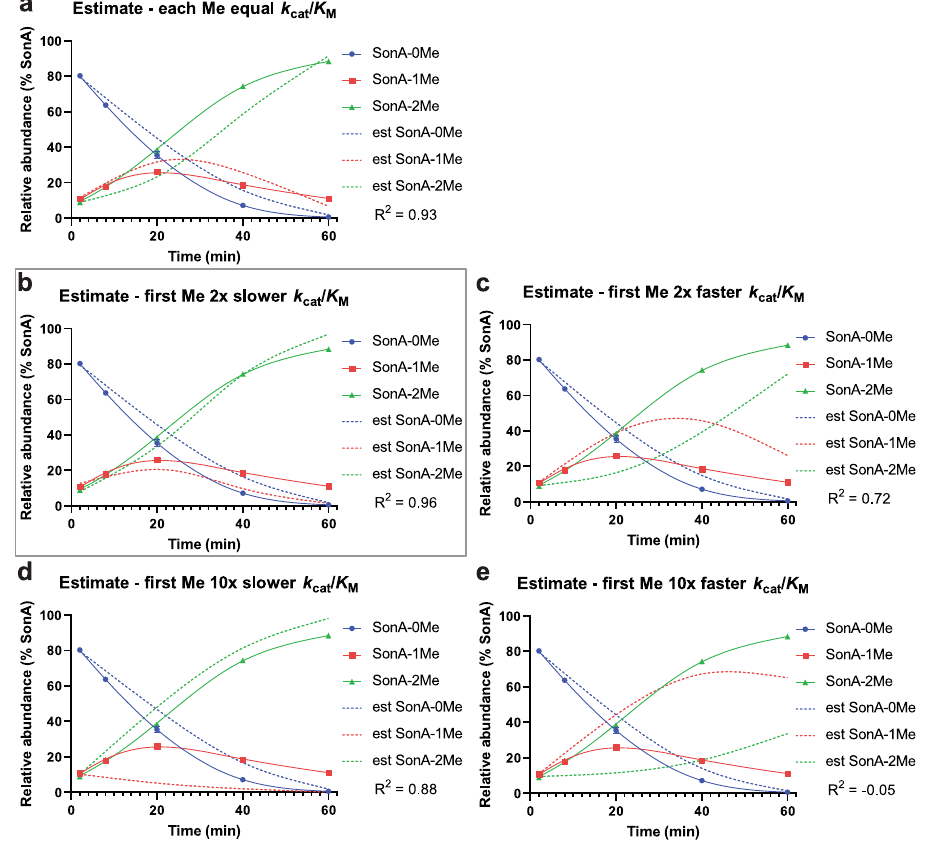
Fig. 4 Kinetics modeling of the iteratively acting α - N -methyltransferase SonM. Graphical comparisons of in silico (dashed lines) and in vitro (solid lines) SonM reactions with the relative levels of substrate (SonA-0Me, blue) and the products of the fi rst (SonA-1Me, red) and second (SonA-2Me, green) methylations plotted. Each graph contains the output of a simpli fi ed kinetics model (see “ Methods ” section) showing the estimated relative abundance of each species of SonA as dashed lines. Each panel contains a simulation for a different combination of relative k cat / K M values for the fi rst and second methylation (Me) events. R 2 represents the fi t of the model to data from two replicates. Data points are fi t against the model prediction for the corresponding species. a Equal simulated k cat / K M values; b the fi rst Me is simulated with a 2× slower k cat / K M value; c the fi rst Me is simulated with a 2× faster k cat / K M value; d the fi rst Me is simulated with a 10× slower k cat / K M value; e the fi rst Me is simulated with a 10× faster k cat / K M value. Relative SonA abundances from duplicate, timed in vitro reactions and observed on LC-MS/MS (solid lines) are overlaid in each plot (Supplementary Fig. 16). The in silico predictions and in vitro data match best in b (boxed in gray), where the second methylation of SonA is predicted to have a modestly higher relative catalytic ef fi ciency than the fi rst methylation of